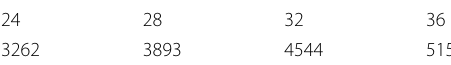
Table 1 Number of dirty pages of first iteration for different memory size VMs mem